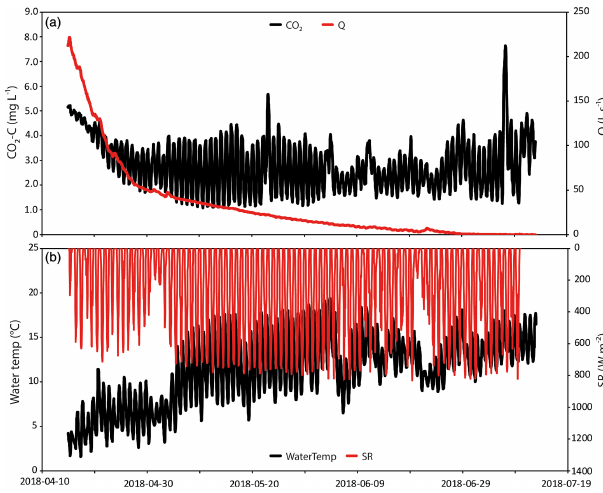
Figure 6. Time series of (a) stream CO 2 concentration (black) and discharge (red) and (b) water temperature (black) and shortwave incoming radiation (SR, red) covering the period April–July 2018. Note the reverse axis for shortwave incoming